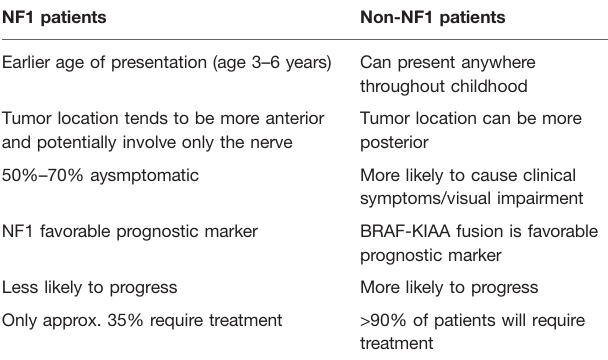
TABLE 1 | Characteristics of OPG is NF1 and non-NF1